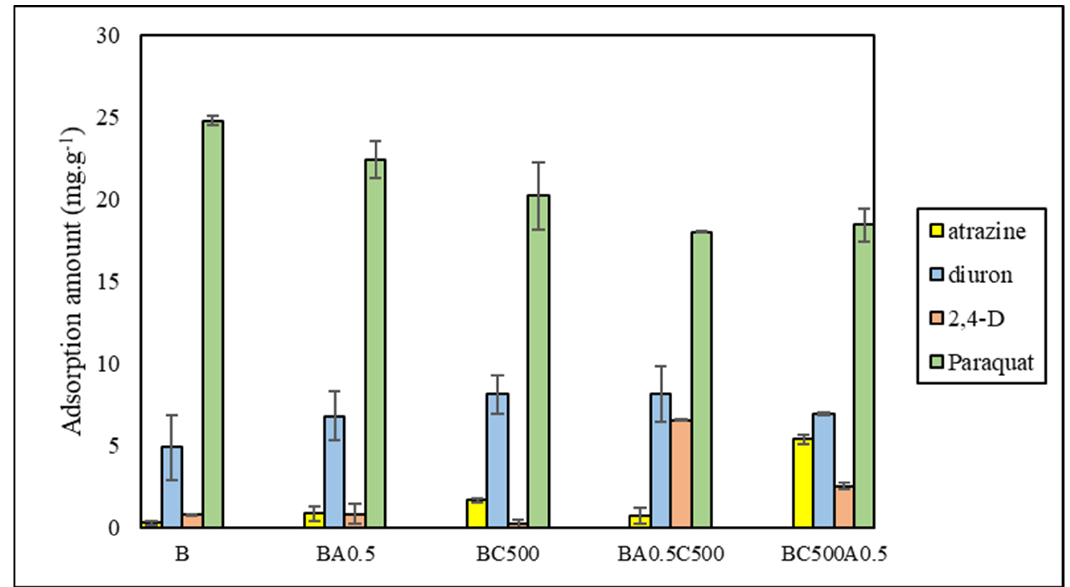
Figure 8. Adsorption of quaternary-component pesticides (with each pesticide 50 mg L − 1 ) at pH 6.5 ± 0.5 onto bentonite and modified bentonite.